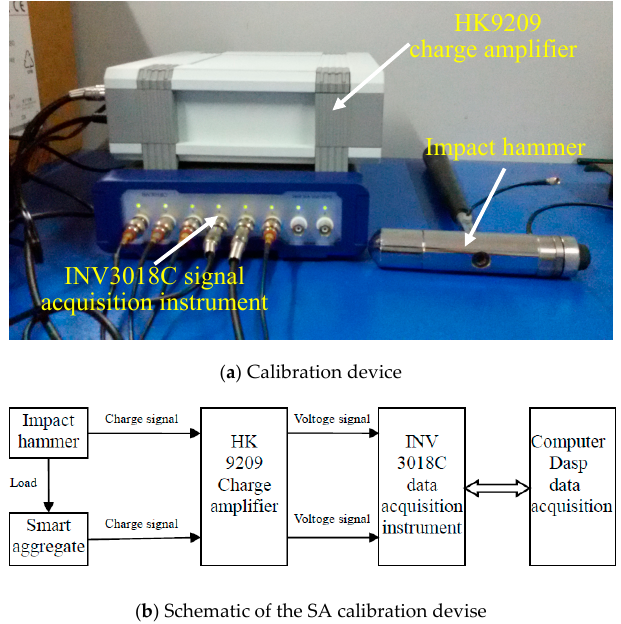
Figure 5. Smart aggregate calibration device under impact load of force hammer.